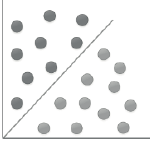
Fig. 1. Linearly separable data . Fig. 2. Linearly inseparable data